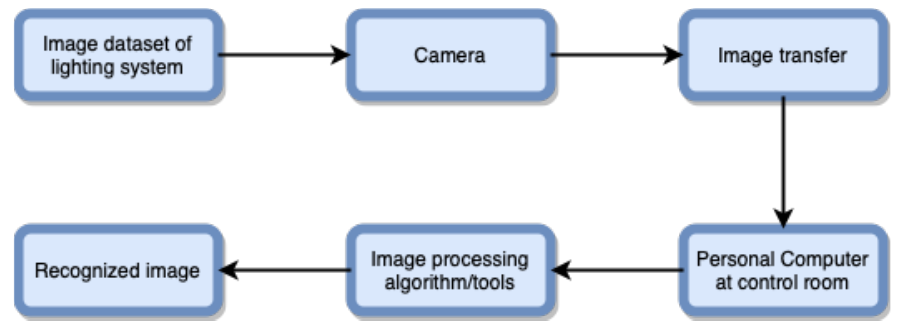
Figure 4. The process of image recognition from multiple cameras into PC.